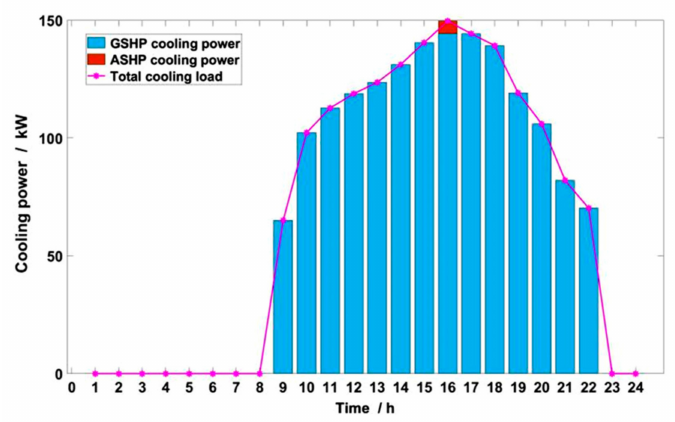
Figure 22. Typical daily cooling power balance in summer.